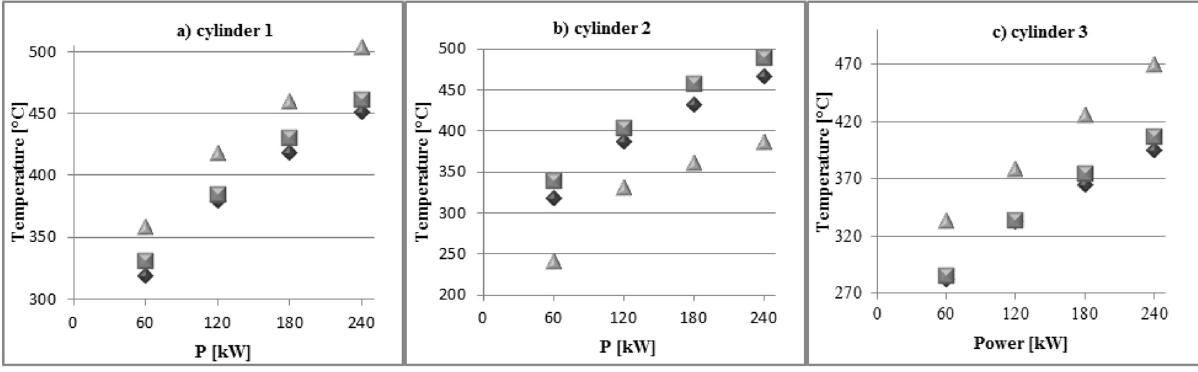
Fig. 2. Exhaust gas temperature behind the cylinder: – engine assumed as operated without malfunctions, – delayed fuel injection, – the leakage of the fuel pump